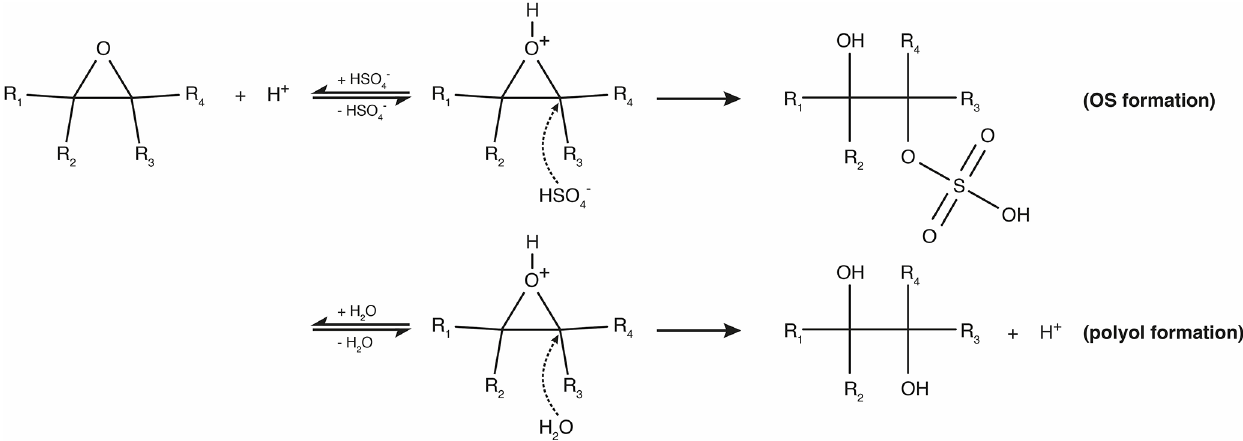
Figure 13. Schematic of the OS and polyol formation via the acid-catalyzed ring-opening reactions of